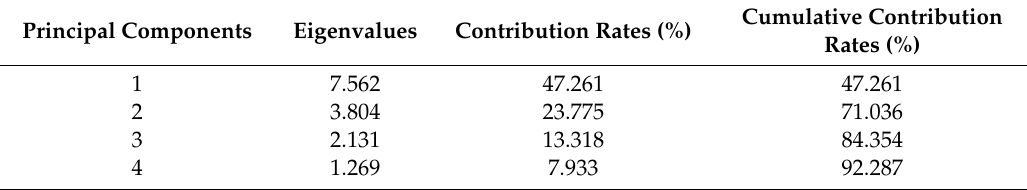
Table 2. Eigenvalues and cumulative contribution rates of principal components.